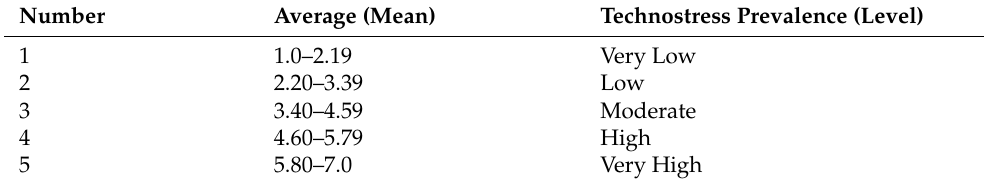
Table 2. The 5-grade average score